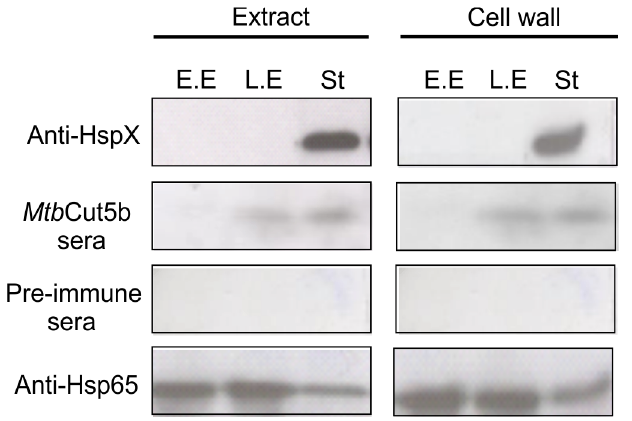
Fig 7. Expression of Cut5b at different in vitro growth phases of Mtb